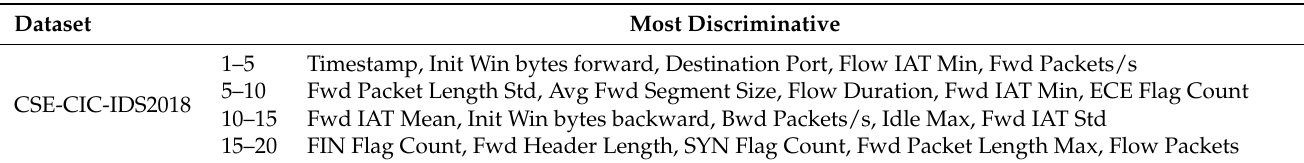
Table 5. Most discriminative features of CSE-CIC-IDS2018 Most